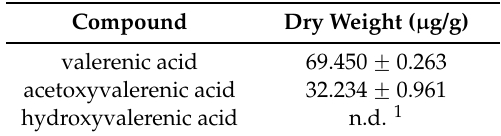
Table 2. Amounts of valerenic acid and its derivatives in V. fauriei